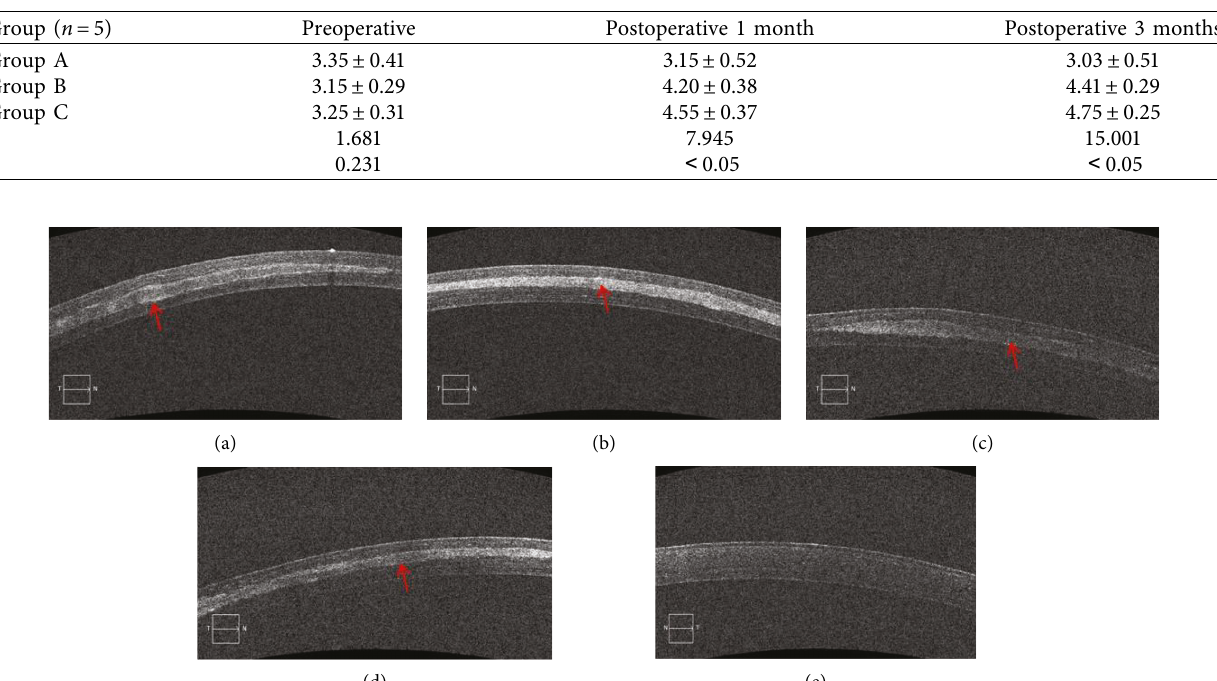
Table 2: Changes in refraction in each group.